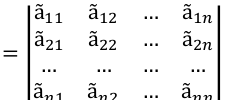
Figure 2. Hierarchical structure of the multi-criteria model Once the hierarchical structure of the model has been completed a series of pairwise comparisons is performed for each element belonging to a certain level, referred to the element present at the immediately higher level.